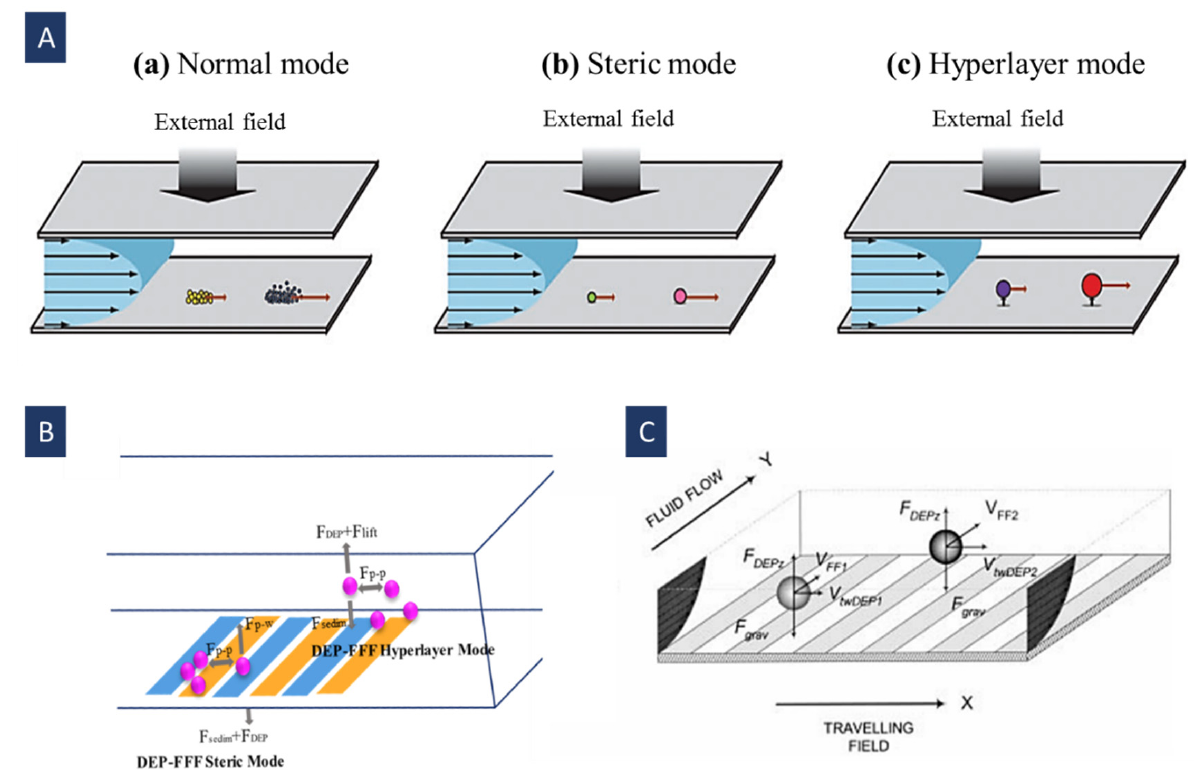
Figure 11. ( A ) FFF operation modes. Different separation mechanisms for particles of various sizes. ( a ) Normal, ( b ) steric, and ( c ) hyper-layer mode (Reprinted with permission from [6]. Copyright 2010, Royal Society of Chemistry); ( B ) forces exerted on the particles in hyper-layer and steric modes in DEP-FFF. The microelectrode array applying The DEP force on the particles is positioned on the accumulation wall. DEP force in steric mode can be positive or negative. This figure depicts the pDEP operation in the steric mode (desired particles are attracted to the electrodes). In the other case, the wall with electrode array is positioned opposite the accumulation wall and negative DEP pushes the target particles towards the accumulation wall. In the hyper-layer case, the particles are levitated away from the electrodes by nDEP force (Reprinted with permission from [114]. Copyright 2021, Elsevier); ( C ) separation of different groups of cells using FFF-DEP along with twDEP (Re- printed with permission from [75]. Copyright 1999, Springer).